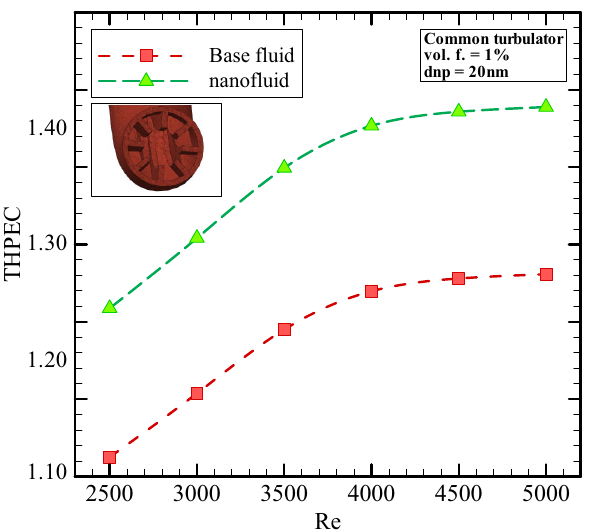
Figure 11. The THPEC index variation versus Re in helical heat exchanger filled with base fluid and nanofluid ( φ = 1% and d np = 20